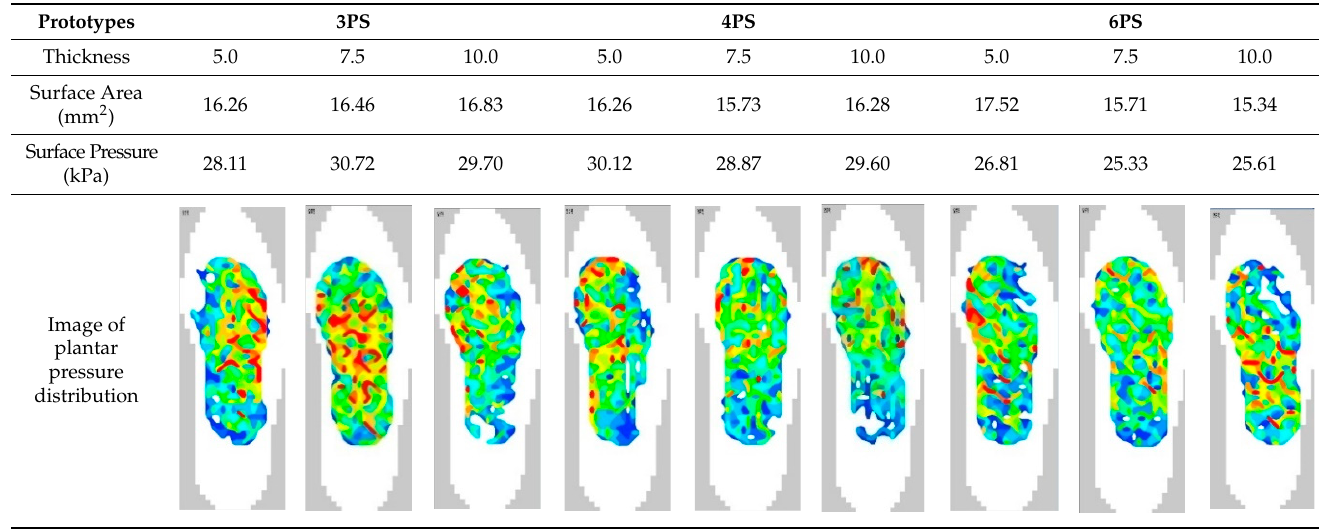
Table 5. The surface area and surface pressure of the LW 3DP 3-, 4-, and 6-PS outsole were measured by an insole sensor tester.